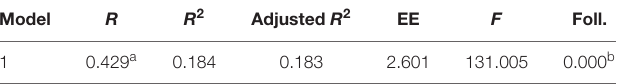
**Significant at the 0.01 (bilateral) level. TABLE 4 | Linear correlation coefficients R , R 2 , adjusted R 2 , EE, and F